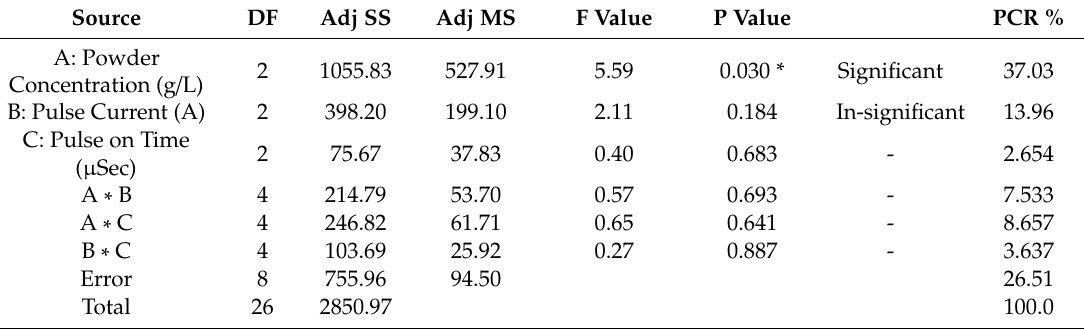
Table 7. Analysis of variance of recast layer